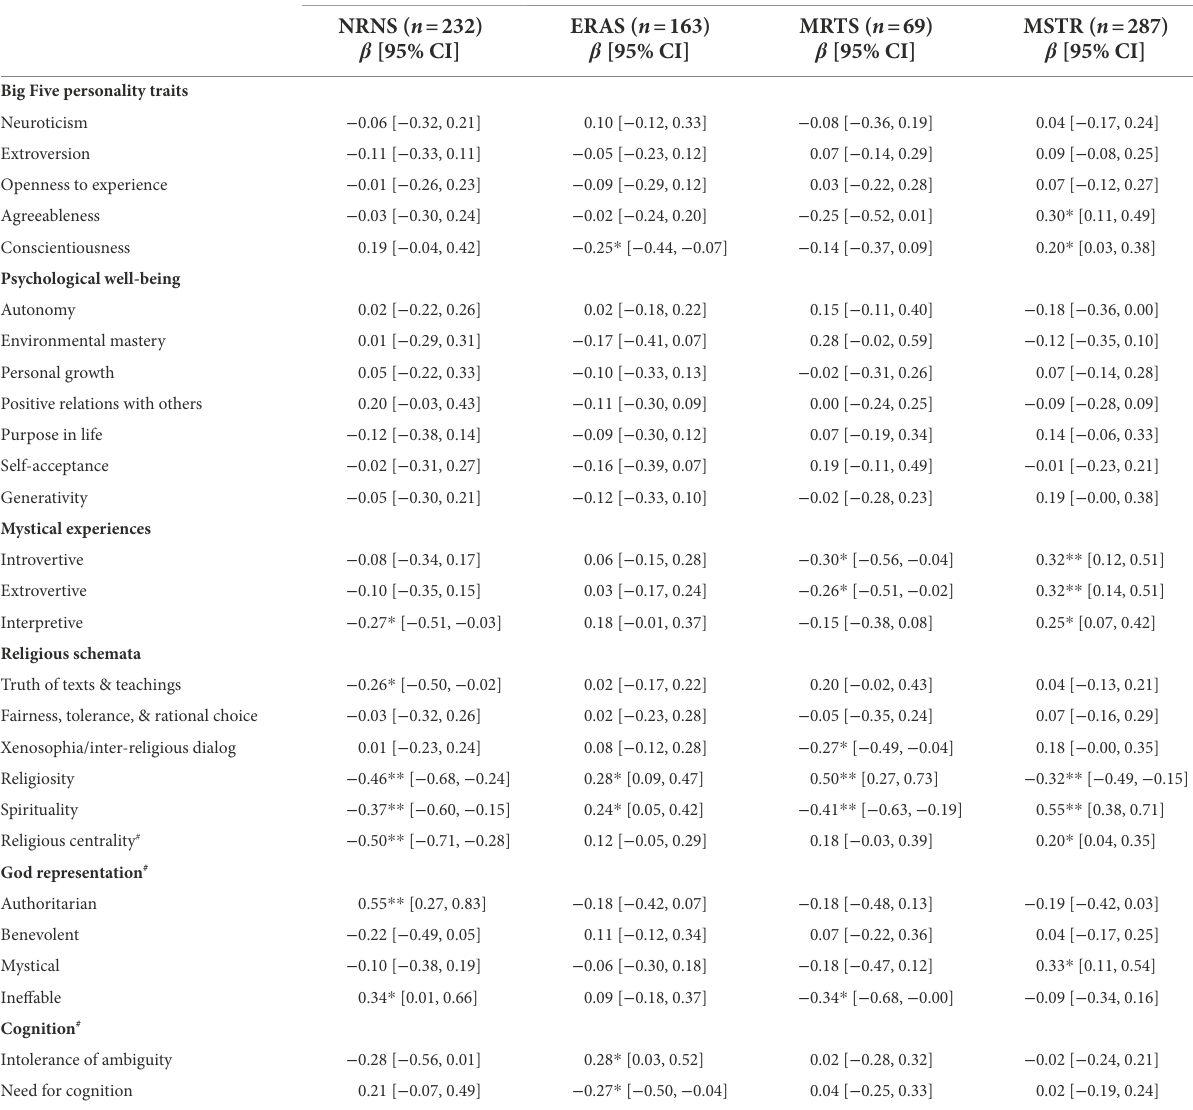
TABLE 2 Associations of religious/spiritual identity (Wave 2) with subsequent outcomes (Wave 3) in Study 2. Outcome Religious/spiritual